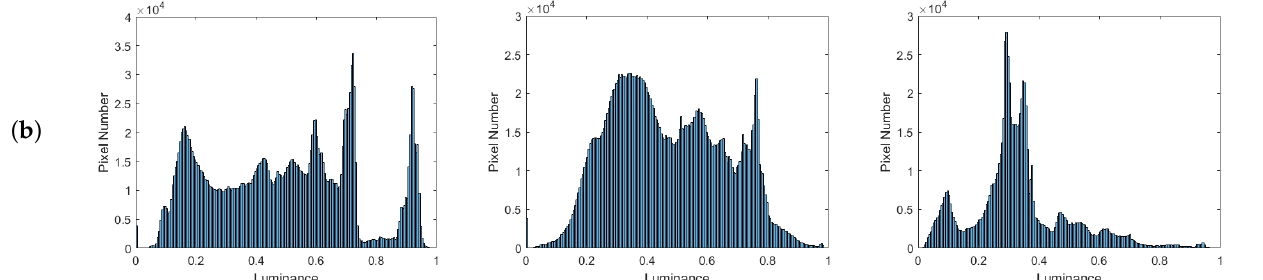
Figure 5. Histogram before and after adaptive logarithmic transformation of different images: ( a ) radiance map; ( b )